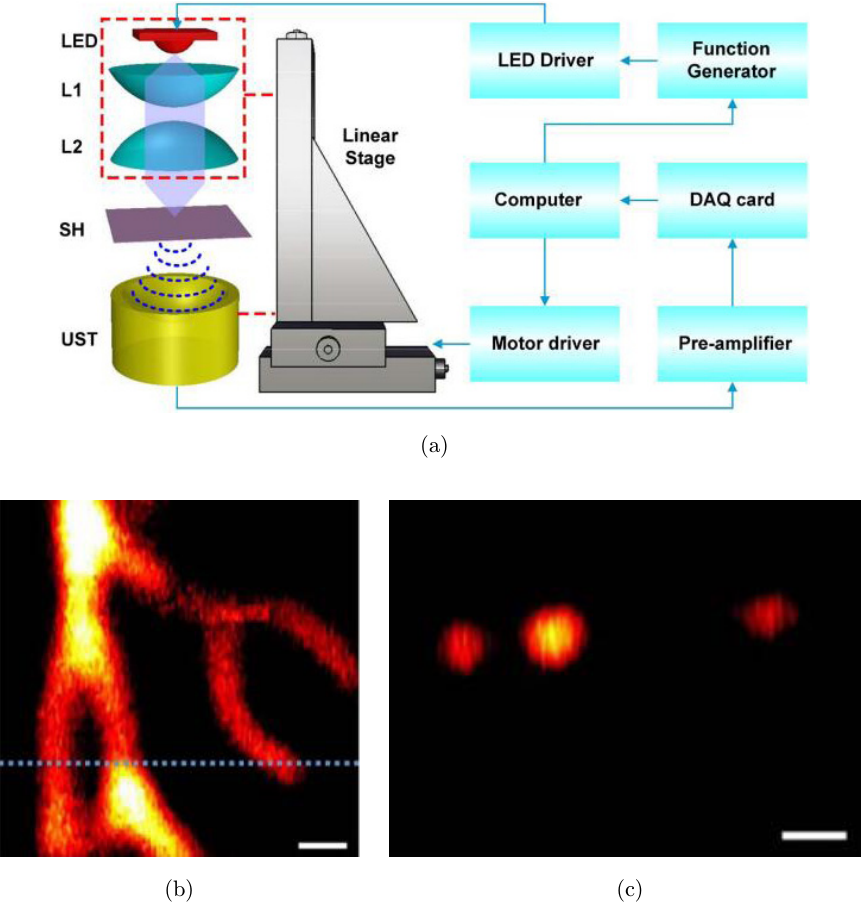
Fig. 11. (a) Schematic of pulsed LED-PAI system, (b) maximum amplitude projection image, and (c) photoacoustic images of the mouse ear the horizontal and depth directions (images adapted from Ref.